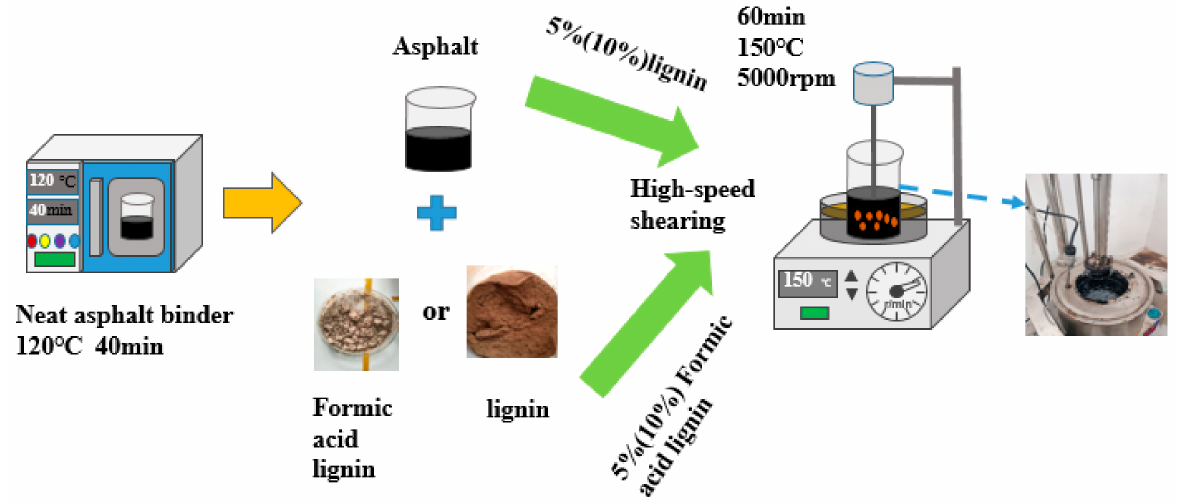
Figure 3. Preparation process of modified